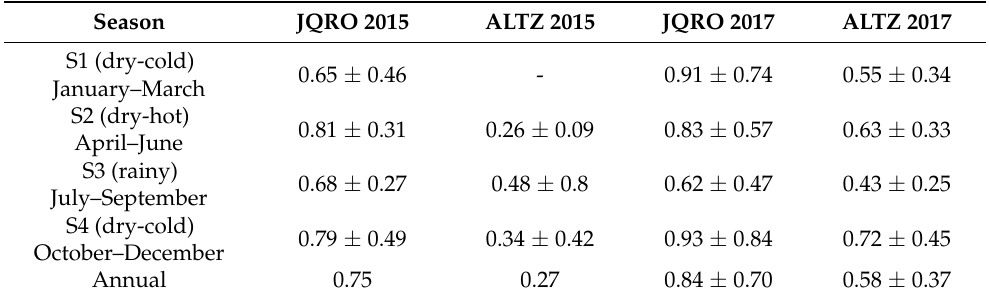
Figure 2. Time series of hourly BC concentrations at ( a ) JQRO and ( b ) ALTZ during 2017. Table 1. Seasonal BC concentrations ( µ g m − 3 ) for JQRO and ALTZ in 2015 (Peralta et al. [18]) and 2017. Average and standard deviations are shown.